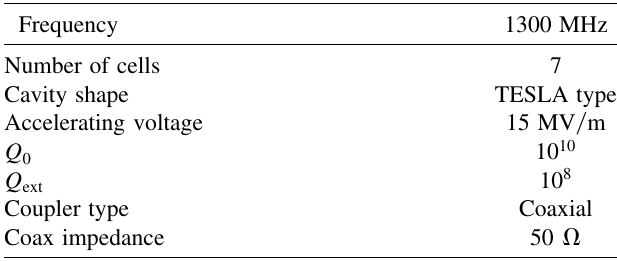
TABLE I. Parameters of accelerating cavities for the Cornell